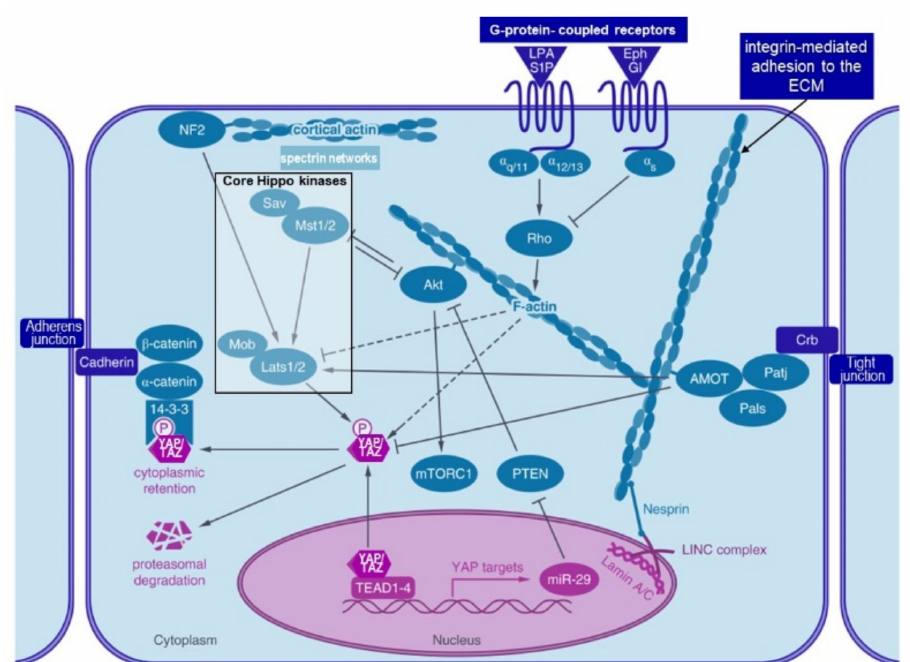
Figure 8. The hippo pathway and the role of YAP and TAZ in mechanotransduction of SC activity. The core components of the hippo pathway are serine/threonine kinases Mammalian Ste20-like 1/2 kinase (MST1/2) and large tumour suppressor 1/2 kinase (LATS1/2), which act to phosphorylate YAP (Yes-associated protein) and TAZ (transcriptional co-activator with PDZ binding motif), to determine the activation state of the pathway. When YAP and TAZ are unphosphorylated they are active and able to enter the nucleus and activate transcriptional enhancer factor, (TEAD)-mediated gene expression. After phosphorylation by LATS1/2 kinase, YAP binds to 14-3-3 proteins, leading to its cytoplasmic retention and also to its degradation. YAP activity is regulated by the actin cytoskeleton which inhibits YAP/TAZ phosphorylation and which is linked to the ECM via integrins. Actin stress fibres connect to the lamin meshwork in the nucleus via the LINC-complex, (Linker of Nucleoskeleton and Cytoskeleton). Rho GPTases are regulated by G-protein coupled receptor signalling which in turn regulates actin dynamics and YAP activity (dashed lines). Actin-binding proteins, like angiomotin (AMOT) or neurofibromin 2 (NF2/Merlin) are also known to regulate YAP activity, either through LATS or by direct interaction with YAP. Akt, a key regulator of the IGF-1-mTOR pathway, also binds to actin stress fibres and crosstalks to the Hippo pathway by interacting with MST1/2 and by YAP-induced expression of a microRNA (miR-29) which inhibits the inhibition of Akt by targeting the phosphatase and tensin homolog, PTEN. Copied and modified from Fischer et al. 2016 [231] with extra detail from